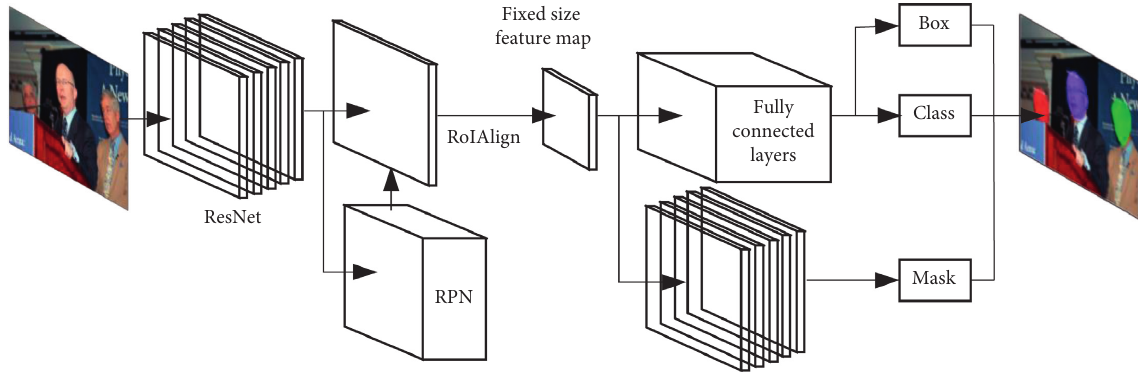
Figure 1: Network architecture of the G-Mask.